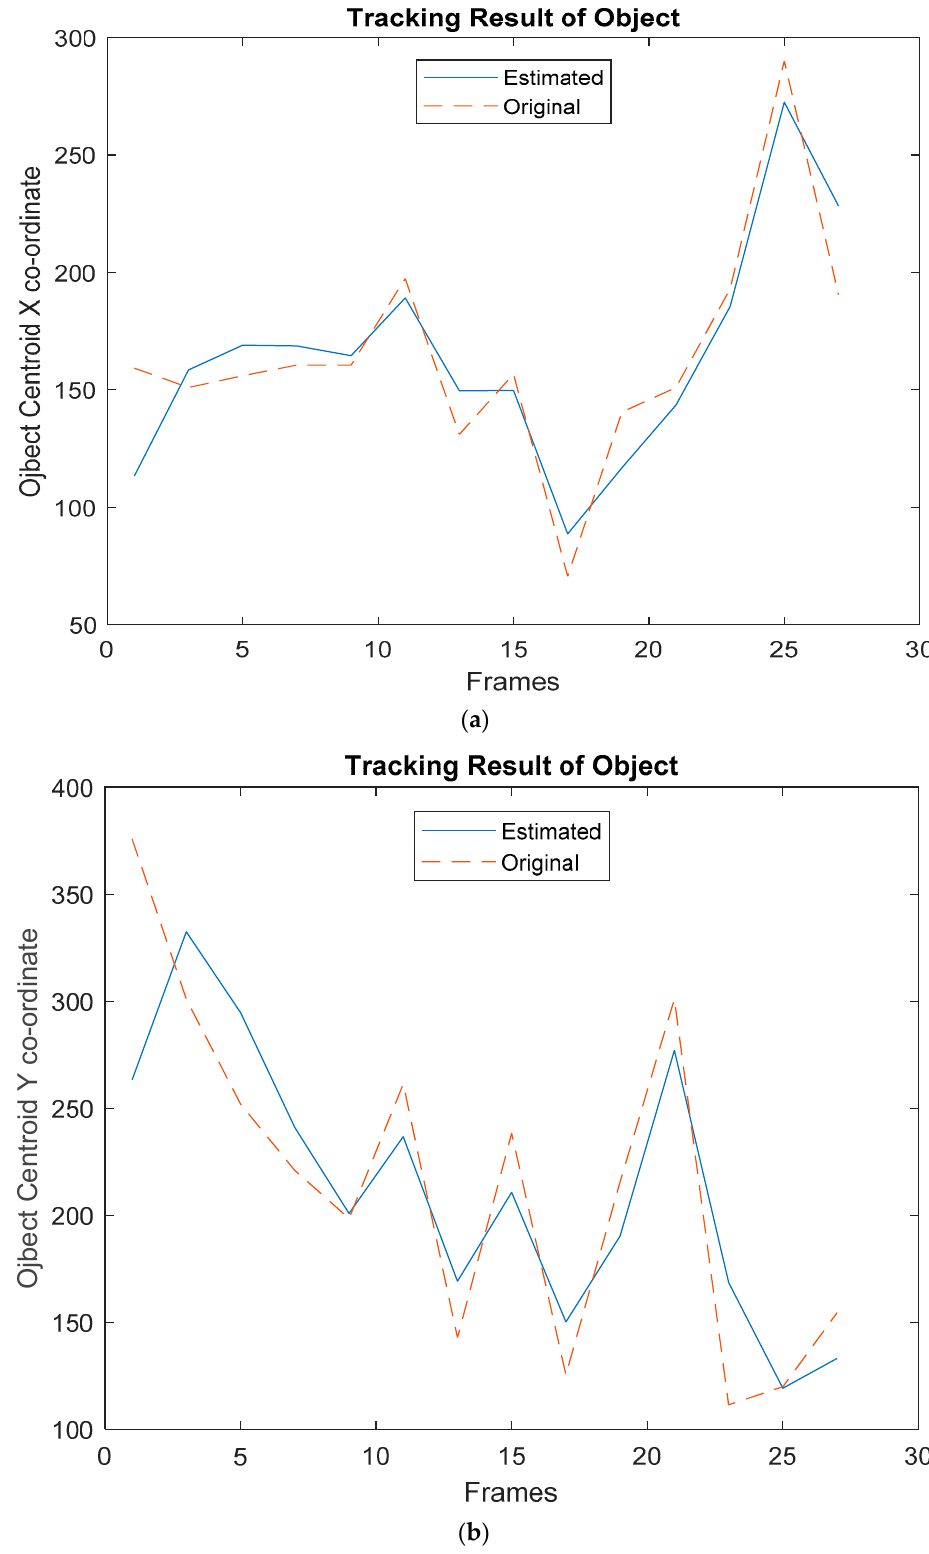
Figure 20. Tracking result of six frames.